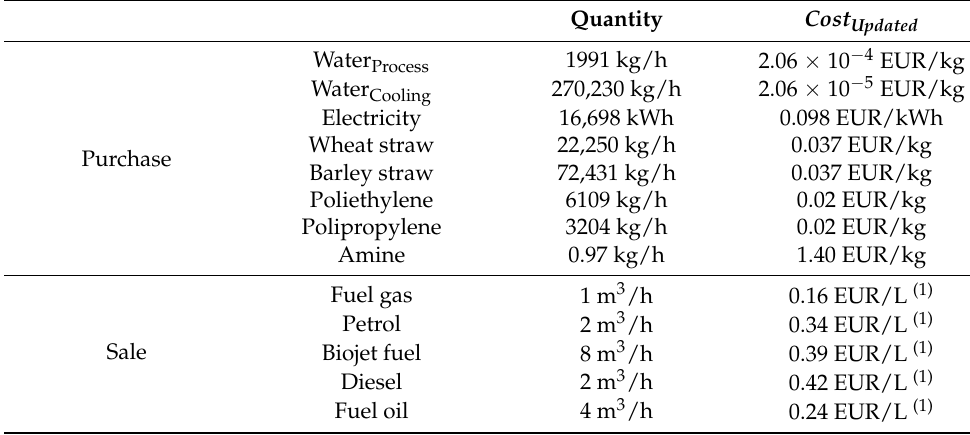
Table 17. Quantity and price of raw materials and products.